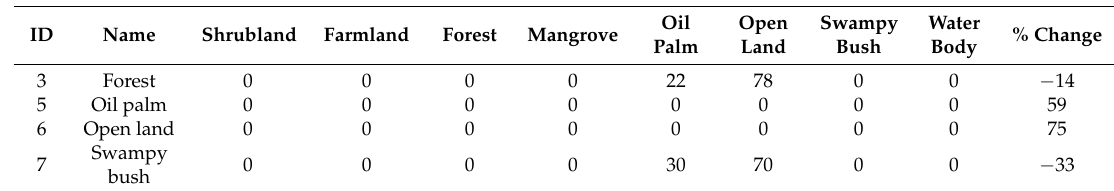
Table A3. BAU Transition Matrix.